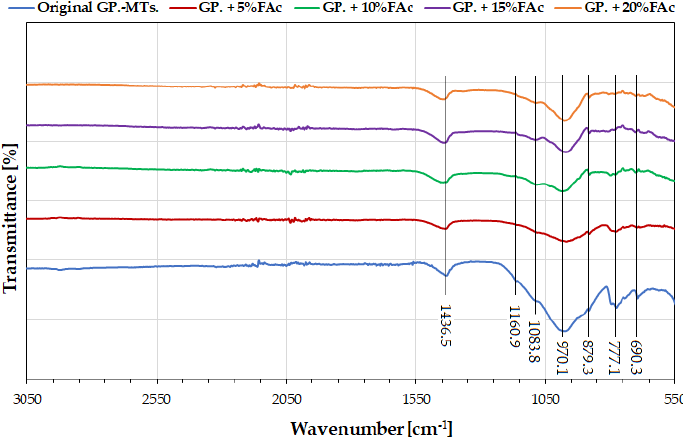
Figure 6. FTIR spectra of the original GP.-MTs, and the supplemented geopolymers with FAc. As the concentration of FAc increased, absorption bands at 777.1 cm −1 and 690.3 cm −1